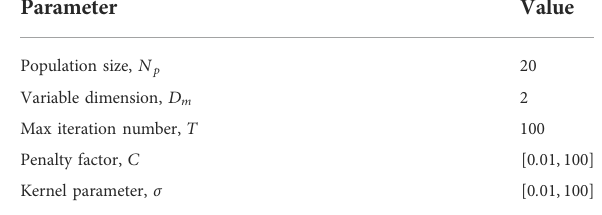
TABLE 1 Parameter setting of the